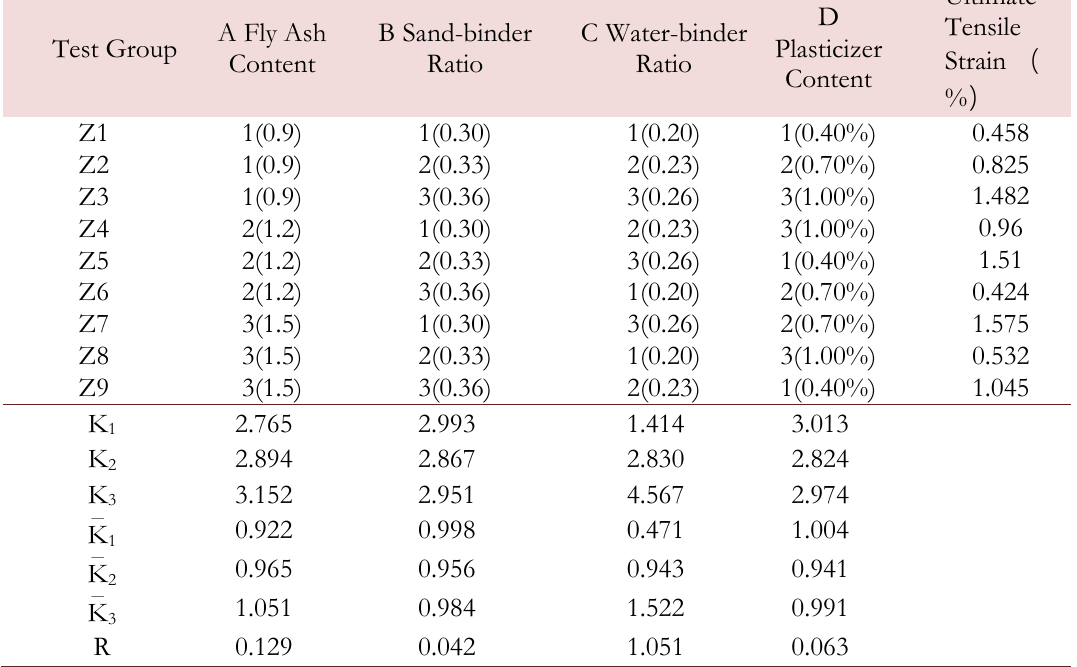
Table 3: Orthogonal Experiment Result of Tensile Property.